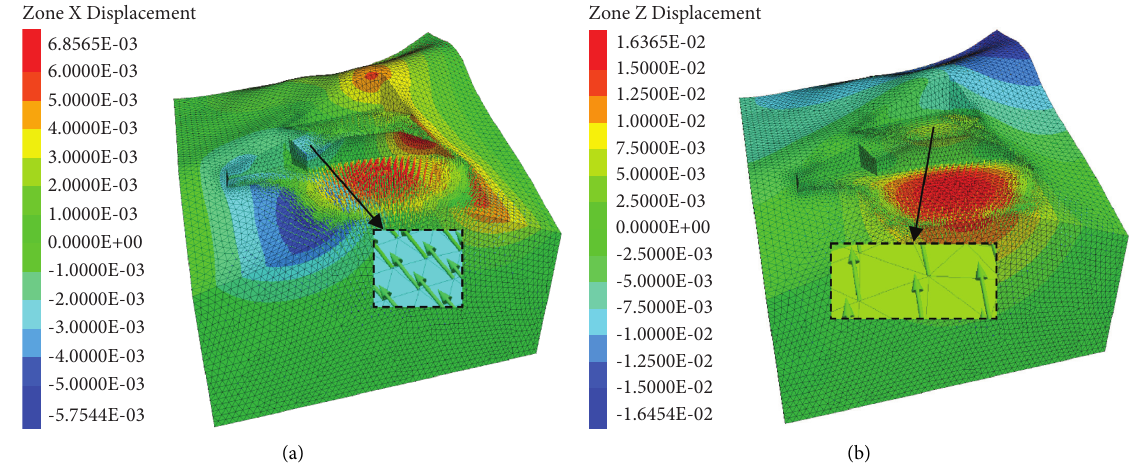
Figure 12: Strain nephogram after third excavation. (a) X -direction strain nephogram and (b) Z -direction strain nephogram.